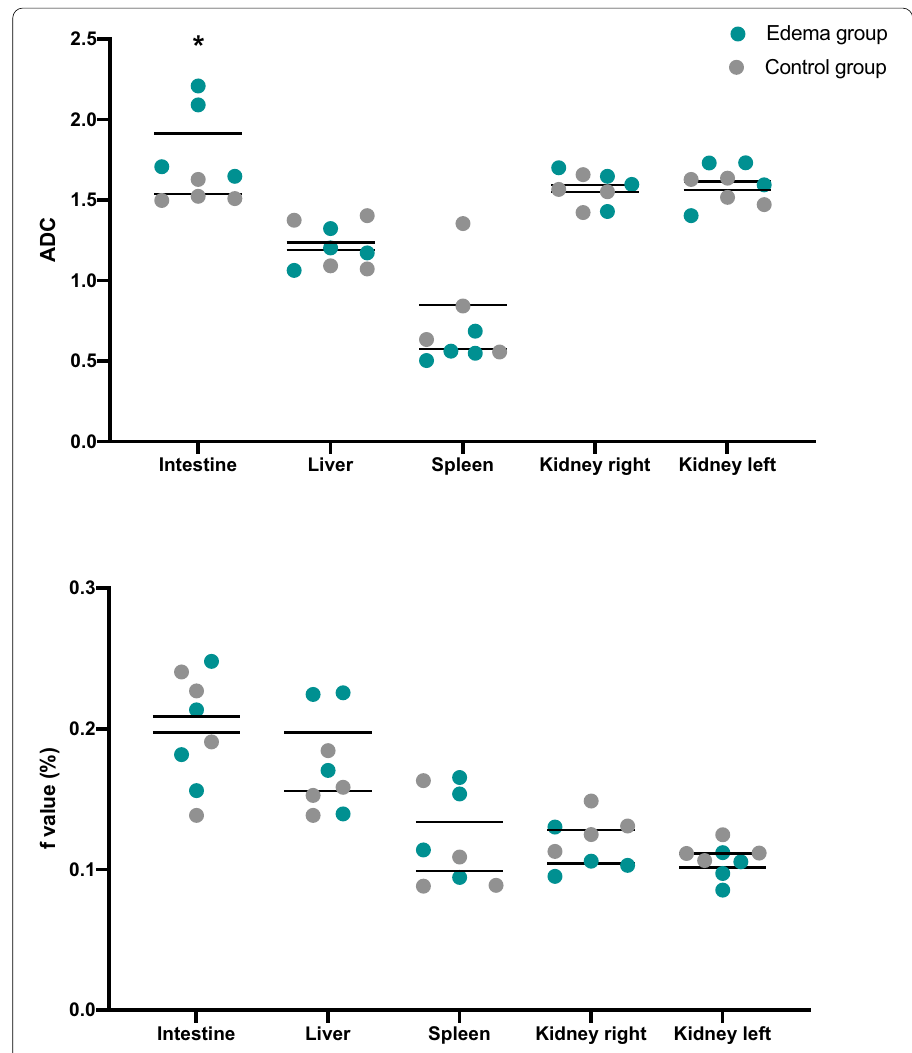
Fig. 3 Data from DW-MR images acquisition. ADC is represented as an adimensional number, f value is represented as a percentage of the total amount of water in the tissue. * p <